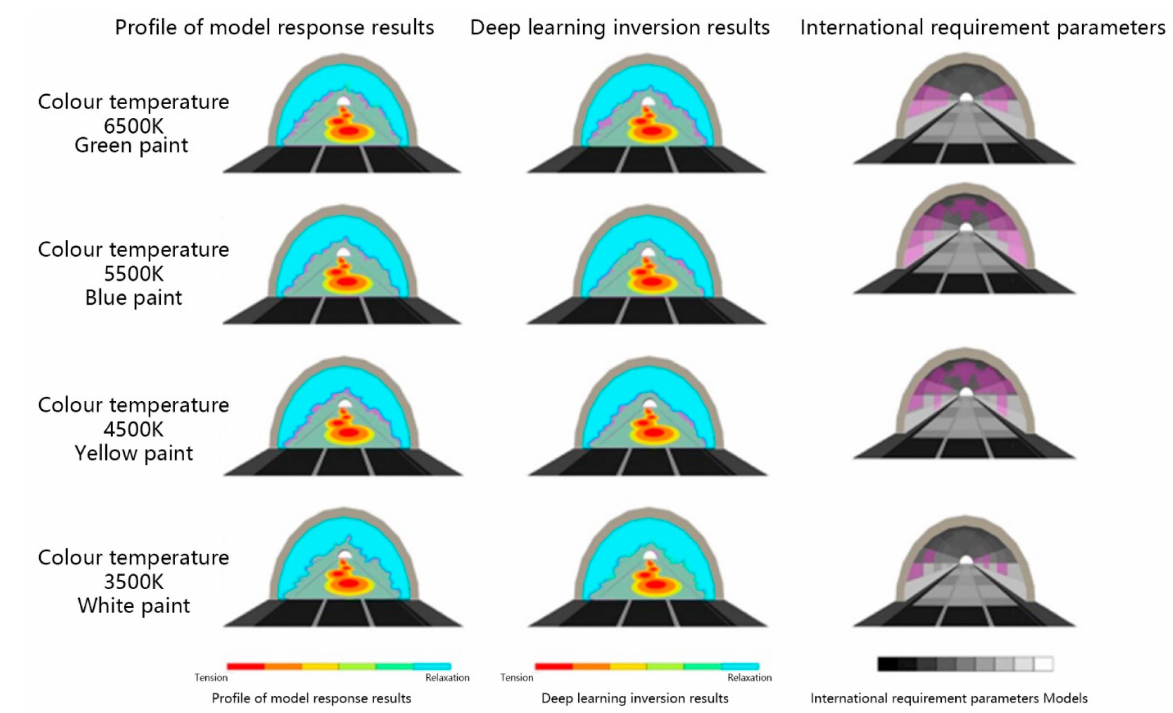
Figure 10. Cross-contrast analysis of tunnel sidewall material color and light source color temperature.